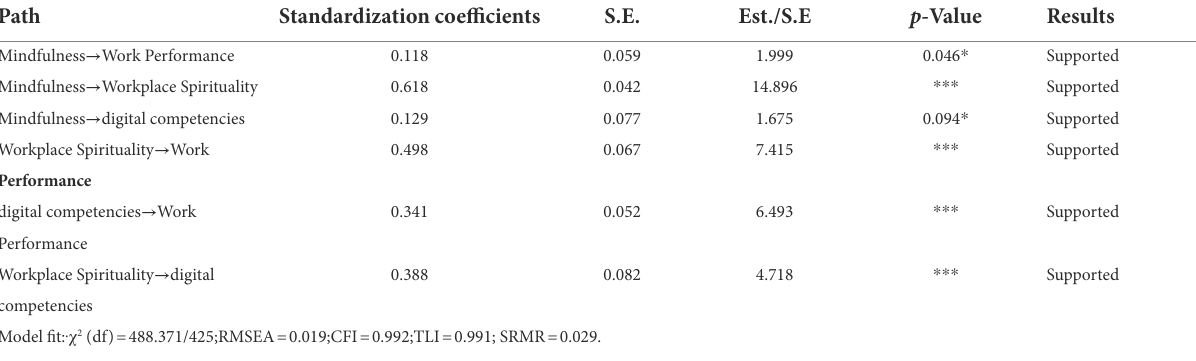
TABLE 6 Structural equation model analysis